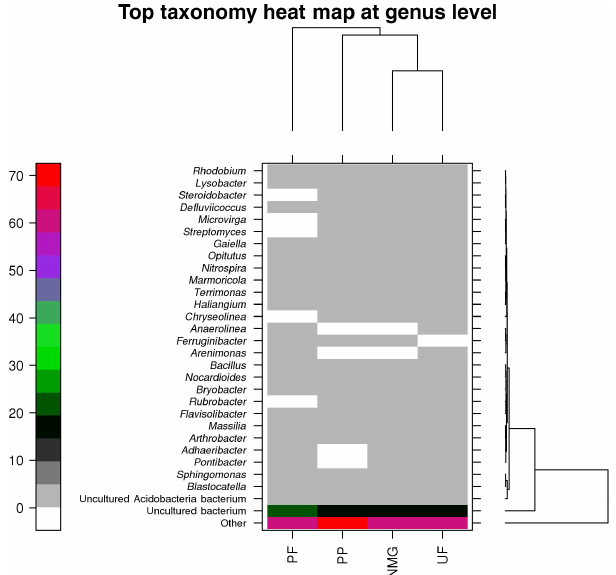
Figure 4. Top taxonomy heat map of soil samples at genus level. NMG: native meadow grassland; UF: 50-year upland field; PF: 26- year paddy field; PP: 34-year poplar plantation.